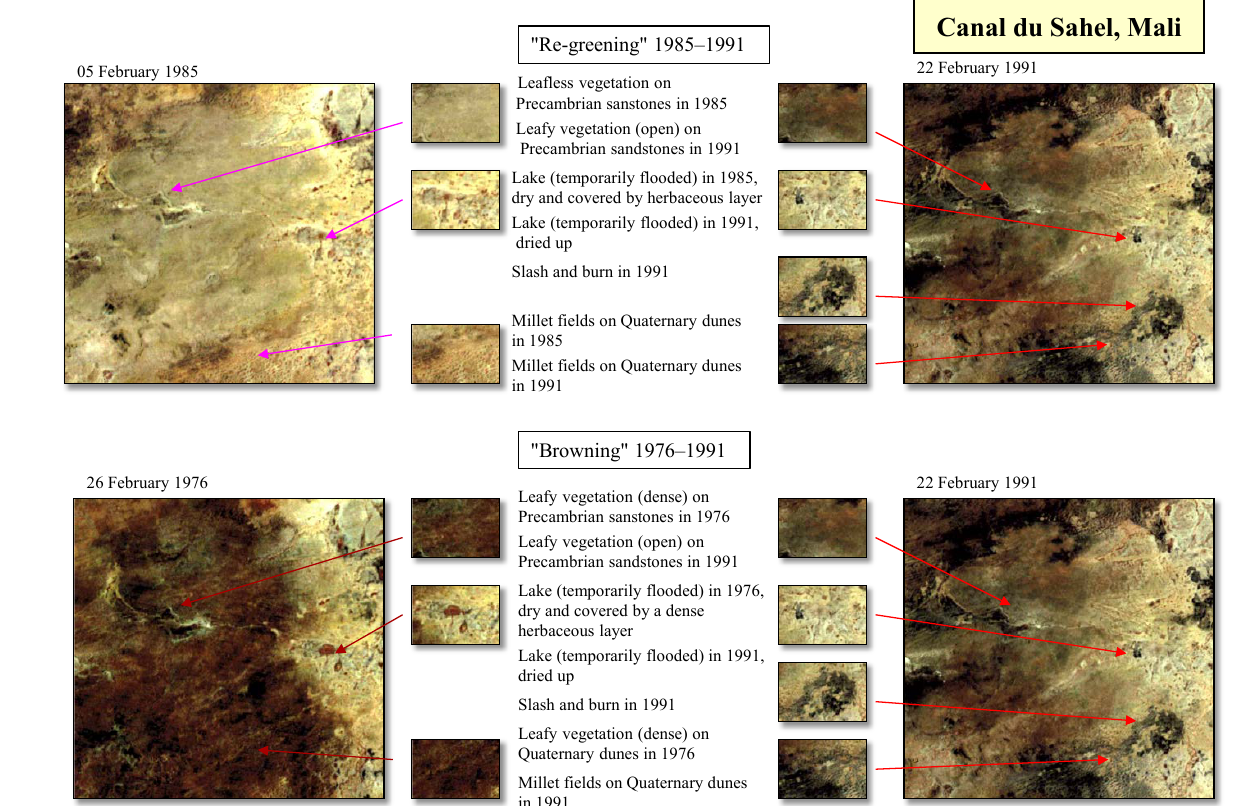
Figure 12. “Re-greening” (period 1985–1991) and “browning” (period 1976–1991) visible in satellite subsets of the Canal du Sahel